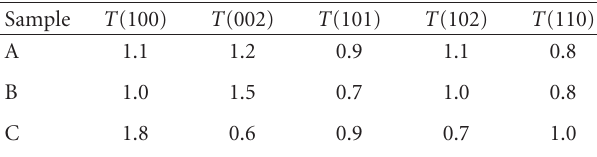
Table 4: Texture coe ffi cients, T ( hkl ), estimated from (100), (002), (101), (102), and (110) reflections, from conventional XRD mea-